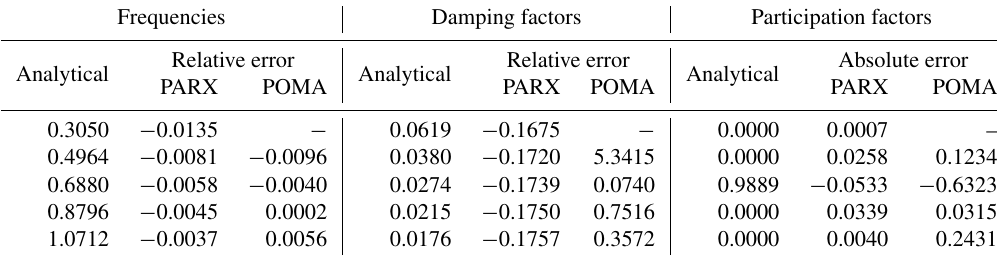
Table 6. Analytical results and estimation errors of in-plane backward whirling modal parameters.